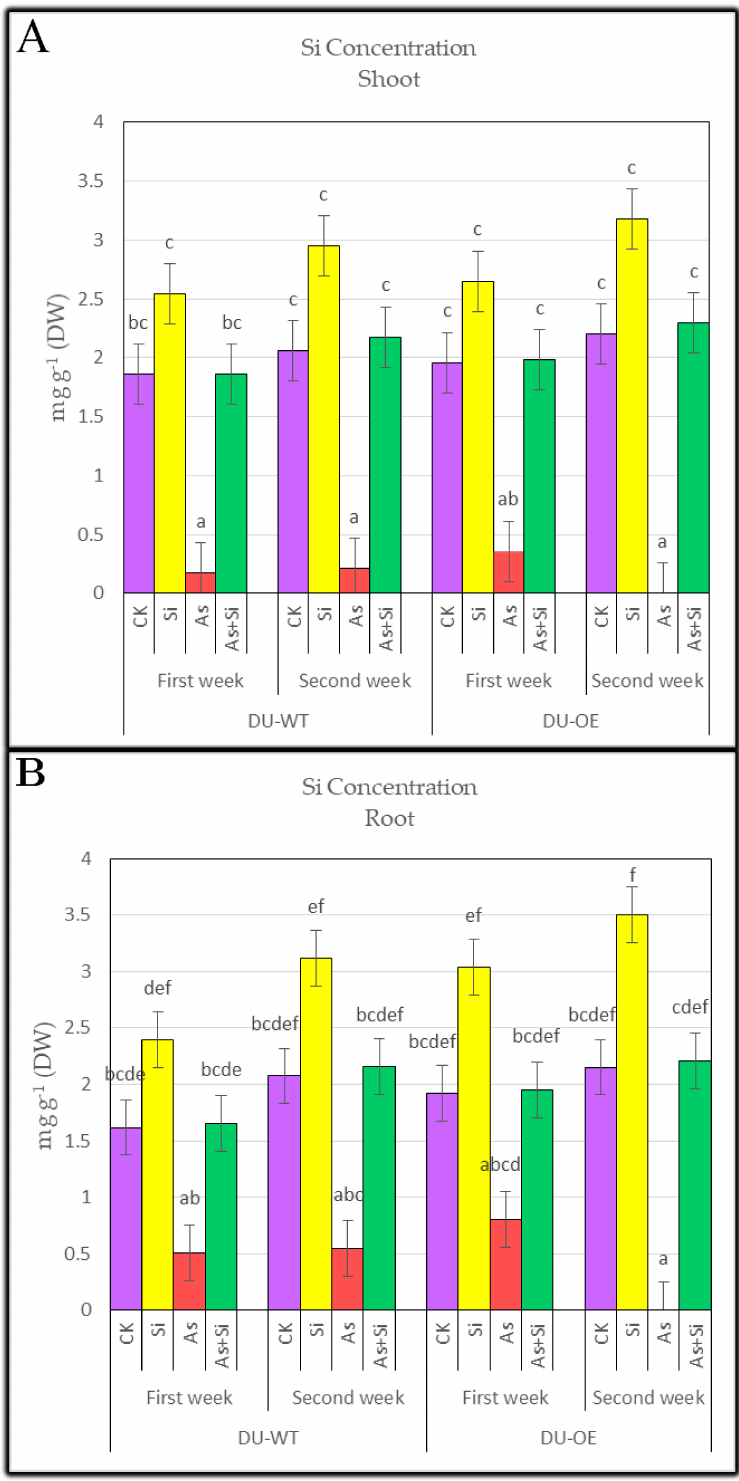
Figure 2. The Si concentration of DU-WT and DU-OE shoots, the first and second weeks after adding treatments ( A ); and the Si concentration of DU-WT and DU-OE roots, the first and second weeks after adding treatments ( B ). The different letters on the bars indicate a significant difference among independent treatment ( p ≤ 0.05); (DW: dry weight; CK: control; Si: 0.70 mM Si; As: 30 µ M As; As+Si: 30 µ M As + 0.70 mM